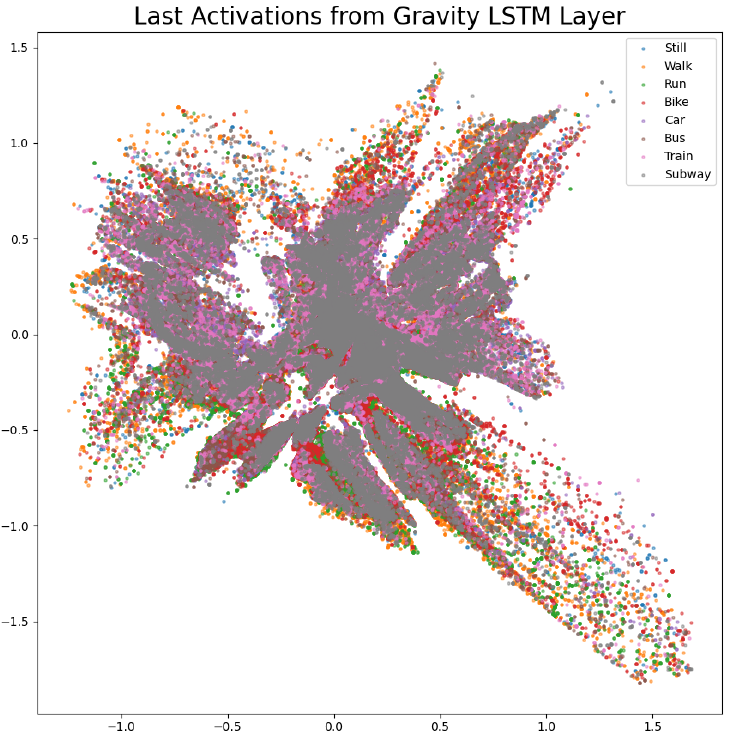
Figure 10. The 2D encoded representation of the last activations of the LSTM layer for the gravity software sensor. Color codes: blue (still), orange (walk), green (run), red (bike), violet (car), brown, (bus), pink (train), grey (subway).